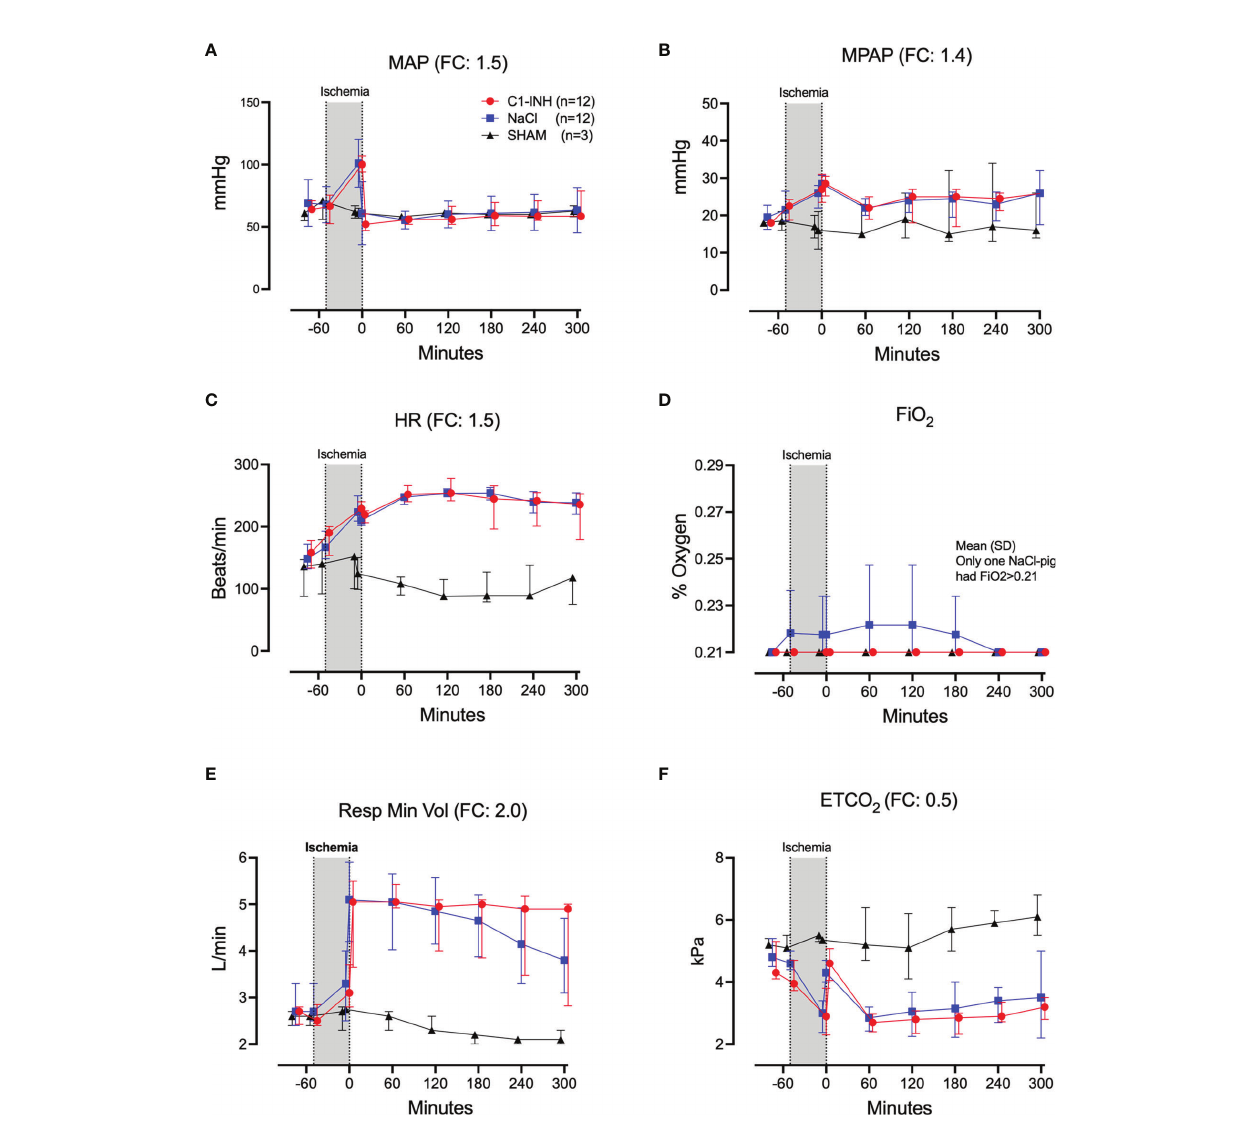
FIGURE 1 | Cardiorespiratory response I. (A) Mean arterial pressure (MAP), (B) mean pulmonary arterial pressure (MPAP), (C) heart rate (HR), (D) fraction of inspired oxygen (FiO 2 ), (E) respiratory minute volume (Resp Min Vol), and (F) end-tidal CO 2 (ETCO 2 ) were measured in 24 piglets undergoing 45 minutes of clamping of the thoracic aorta at the Th8 level. Upfront 12 piglets received human saline and 12 received C1-INH (250 IU/kg) intravenously, respectively. Three sham animals received thoracic opening without clamping. Reperfusion started at 0 minutes and lasted 5 hours. Longitudinal time data are expressed as median and interquartile range. “ Ischemia ” indicates the 45 minutes period of clamping. NaCl and C1-INH-groups were combined when there were no differences in the fold change (FC) calculation. FC is the change from before cross-clamp onset to maximum